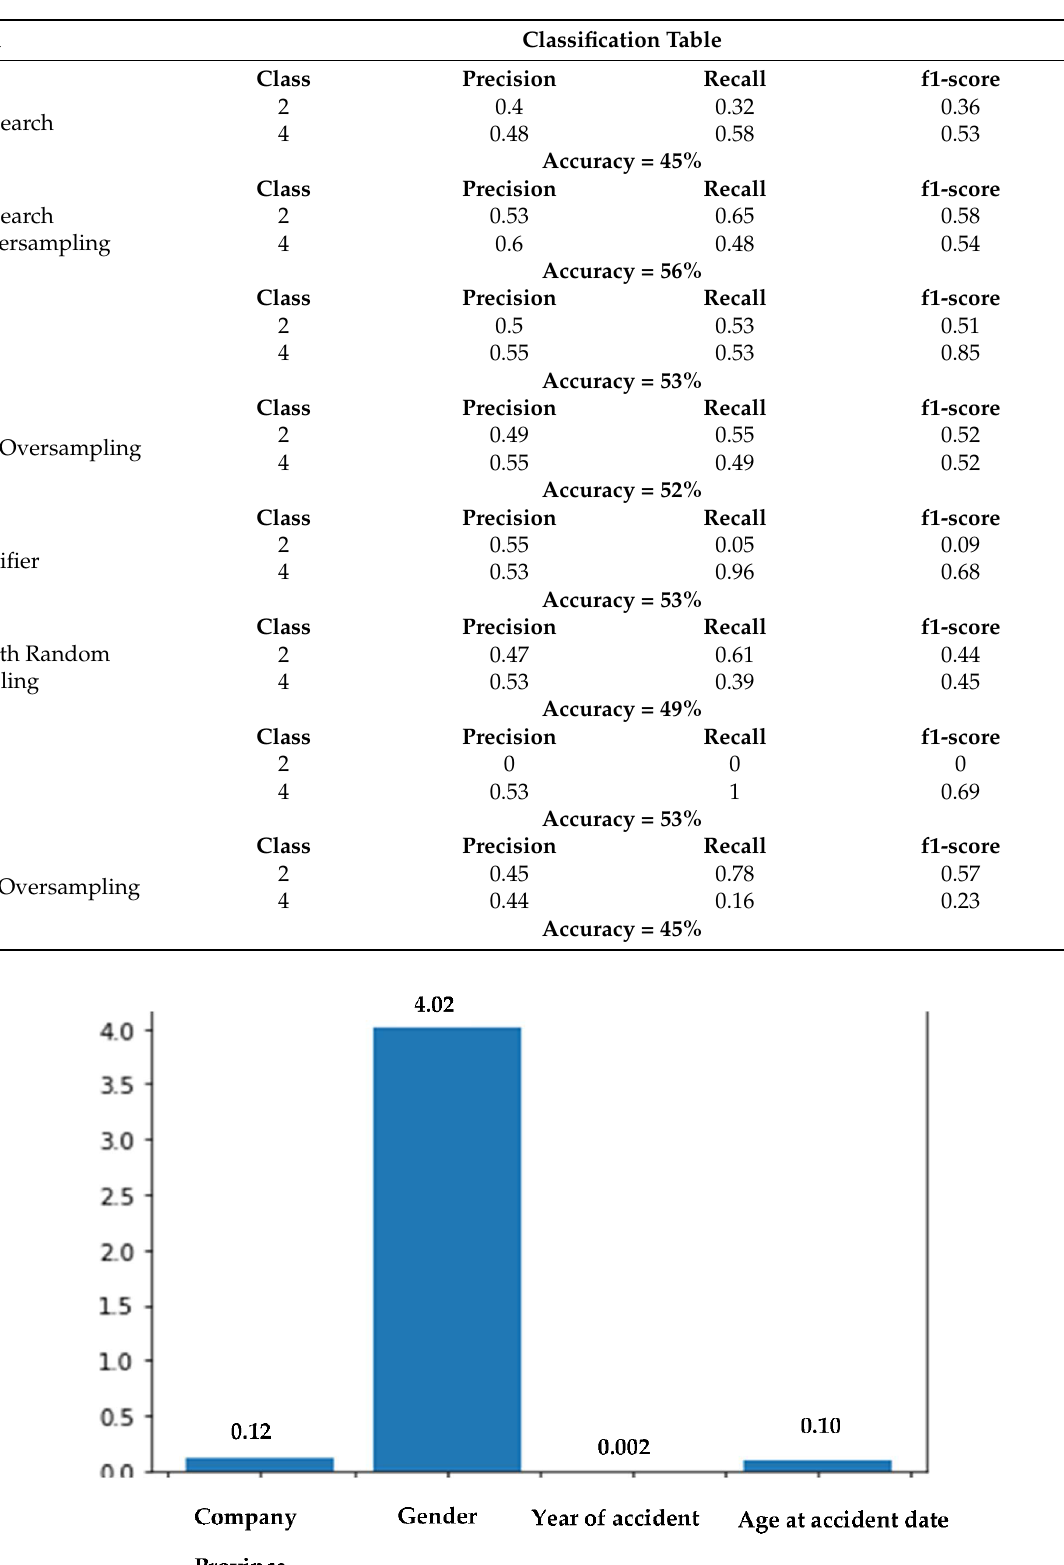
Table 4. Classification tables of the models for prediction of injuries in the lower extremity injuries and injuries in the Torso and Hand Region.